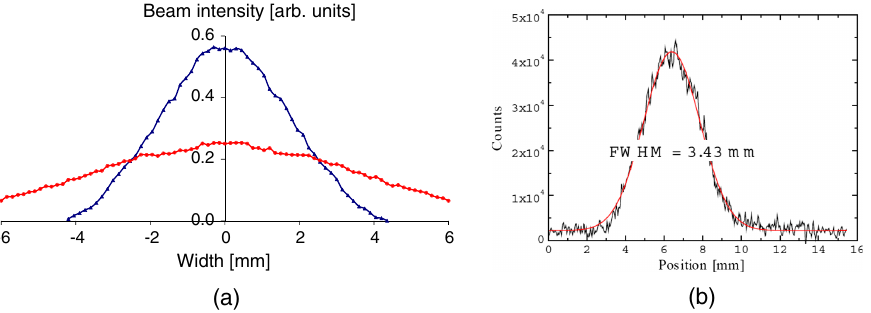
FIG. 4. Beam profile of 18.4 keV Mg þ ions in the ELISA ring with spherical deflectors: (a) BETACOOL simulations. The blue curve corresponds to a ring acceptance of A ¼ 6 (cid:4) mm mrad ( (cid:11) ¼ 1 : 5 (cid:4) mm mrad ) while the red curve is a predicted beam profile assuming a ring acceptance of 50 (cid:4) mm mrad ; (b) measured profile, corresponding to a ring acceptance of about 5 (cid:4) mm mrad ( (cid:1) x ¼ 3 : 5 m ), plot taken from